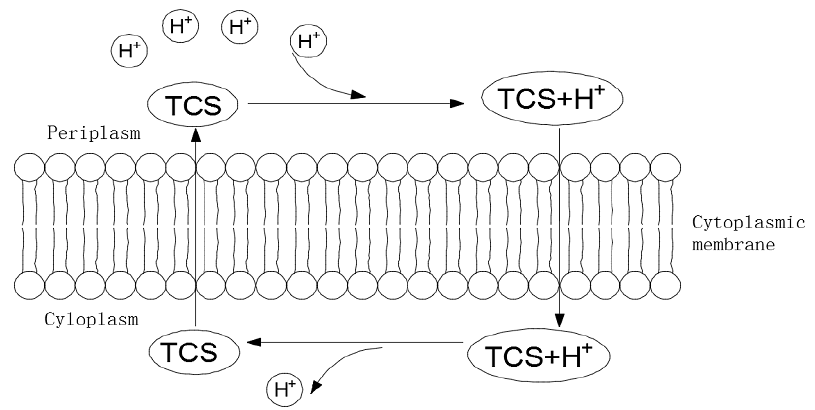
Figure 5. Mechanism of excess sludge reduction induced by TCS.